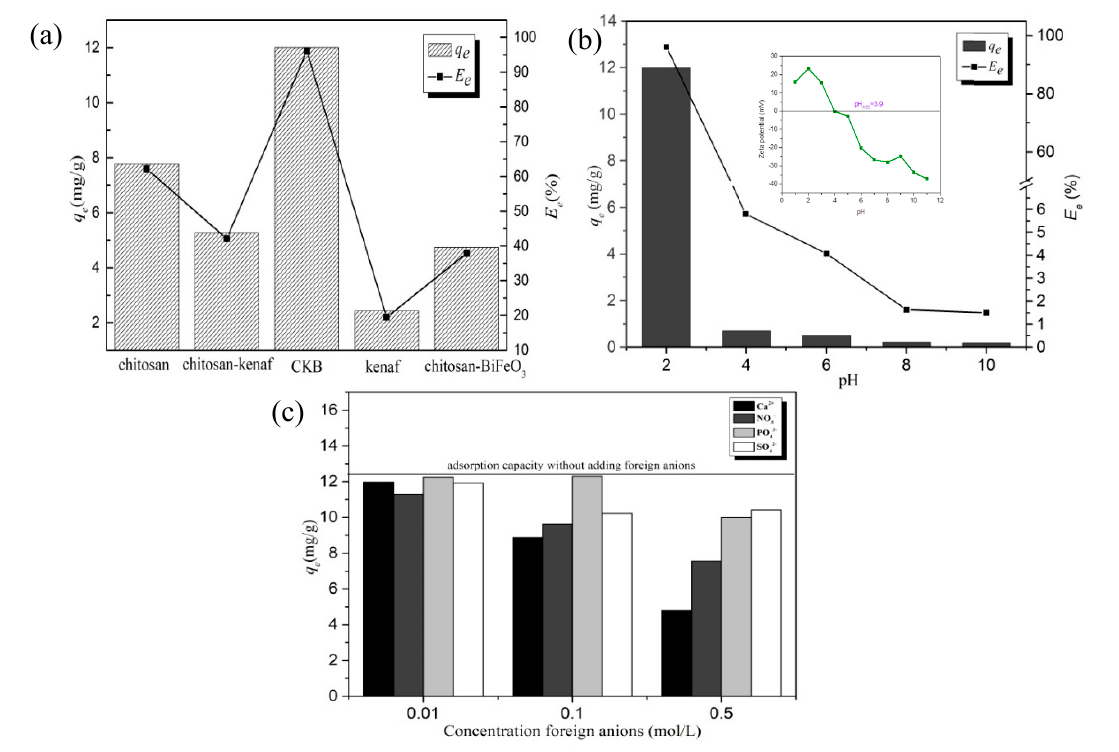
Figure 4. ( a ) Comparison of adsorption capacity among chitosan, chitosan- kenaf biochar, chitosan-BiFeO 3 , CKB and kenaf biochar: C 0Cr(VI) = 50mg/L, W = 0.2 g, T = 30 °C, t = 4 h, pH = 2, ( b ) Effect of solution pH on Cr(VI) adsorption onto CKB: C 0Cr(VI) = 50 mg/L, W =0.2 g, T = 30 °C, t = 4 h, ( c ) Effect of Ca 2+ , NO 3- , PO 43- , and SO 42- on Cr(VI) adsorption onto CKB: C 0Cr(VI) = 50 mg/L, W = 0.2 g, T = 30 °C, t = 4 h, pH = 2.